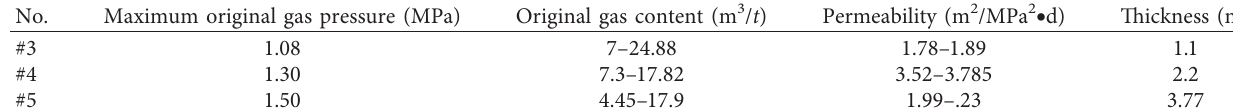
Table 1: Basic parameters of the coal seams.